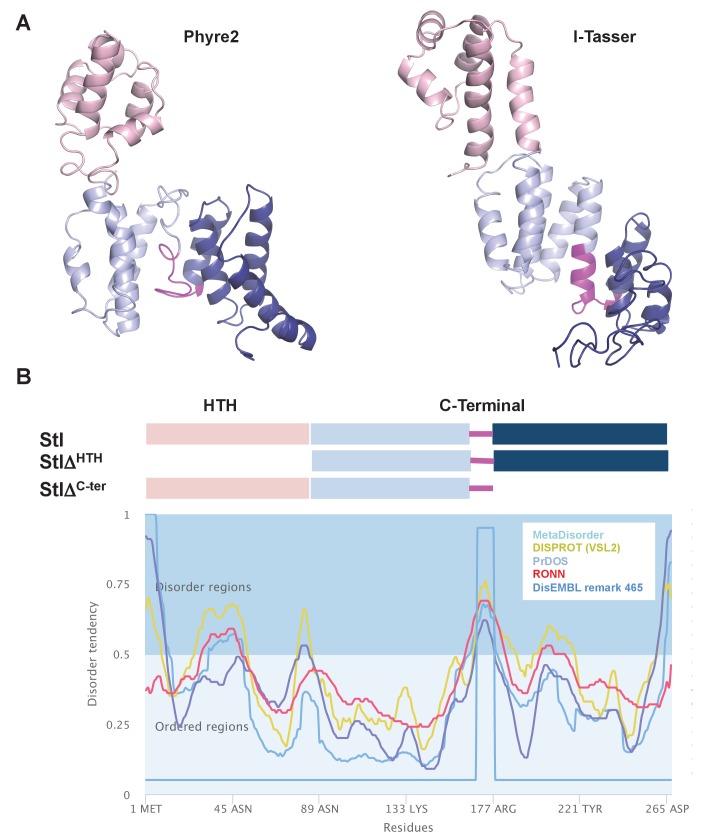
Stl models and constructs design.(A) Cartoon representation of SaPIbov1 Stl models produced by Phyre2 and I-Tasser servers. Both servers predict models with high α helical content that can be divided in to a N-terminal HTH domain (pink) and a C-terminal portion (light and dark blue) separated by a region of low complexity (magenta) as is predicted by the Metadisorder server. (B) Based on these predictions, two deletional Stl constructs were designed: StlΔHTH, lacking the N-terminal HTH domain, and StlΔCter lacking the C-terminal portion after the predicted disorder region.